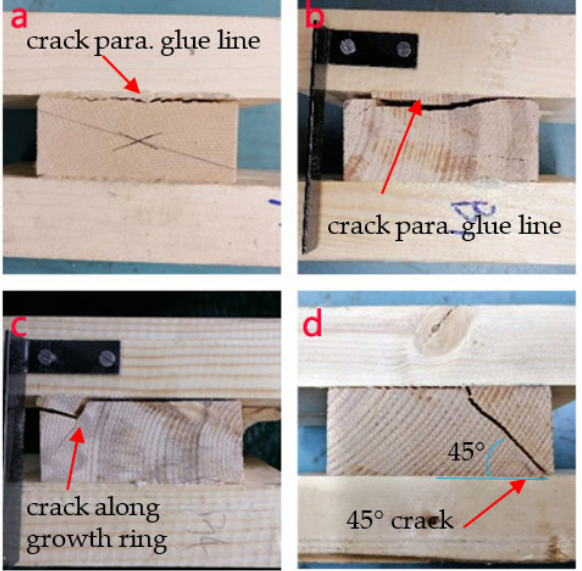
Figure 4. Failure modes of 89 mm × 35 mm specimens: ( a ) Group I-0, ( b ) Group I-90, ( c ) Group I-90, ( d ) Group I-45.